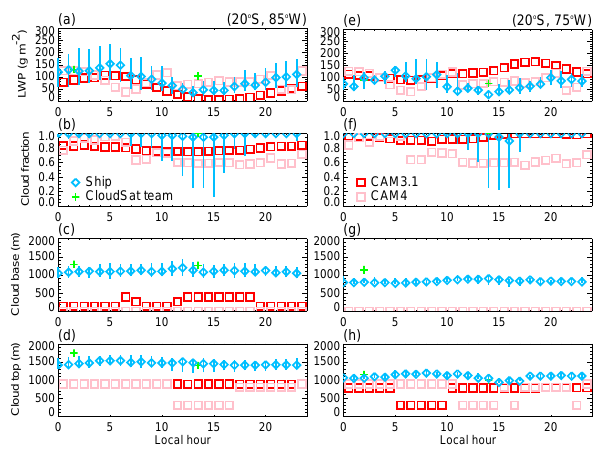
Figure 6. Same as Figure 4 showing only data from the 2001-2007 Stratus cruises (light blue diamonds, with the interquartile ranges indicated by the vertical lines) and the CloudSat team products including LWPs with suspected precipitation contamination removed and adiabatic cloud bases based on thicknesses from Eq. (1) only with simulated quantities from CAM3.1 and CAM4.